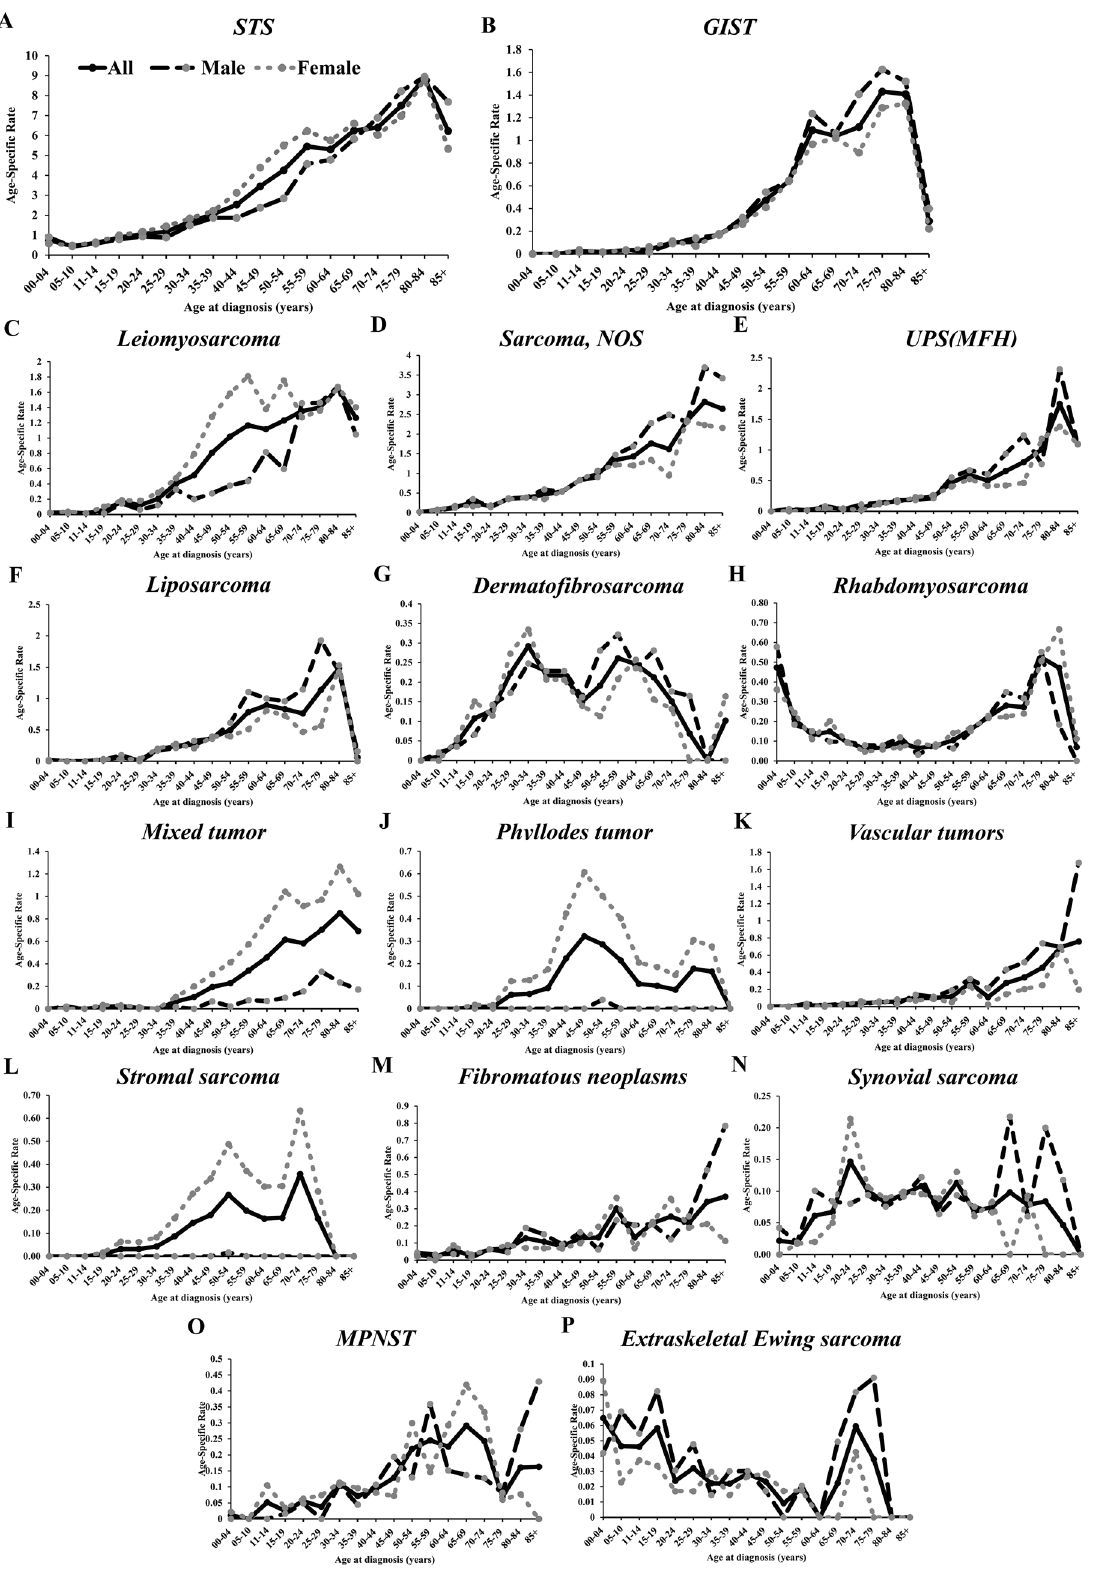
Figure 1. Age-specific incidence rates of STS and GIST by major histological type and sex. STS soft tissue sarcoma, GIST gastrointestinal stromal tumor, NOS not otherwise specified, UPS Undifferentiated pleomorphic sarcoma, MFH malignant fibrous histiocytoma, MPNST malignant peripheral nerve sheath